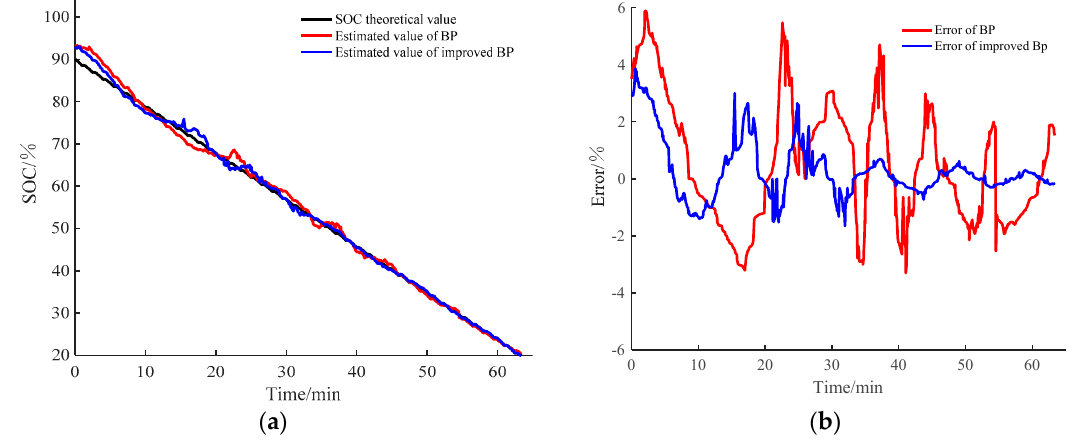
Figure 9. SOC comparison diagram of working condition experiment: ( a ) Comparison curves between different estimation methods and SOC theoretical values; ( b ) the error curves of the two estimation methods compared with the theoretical values.